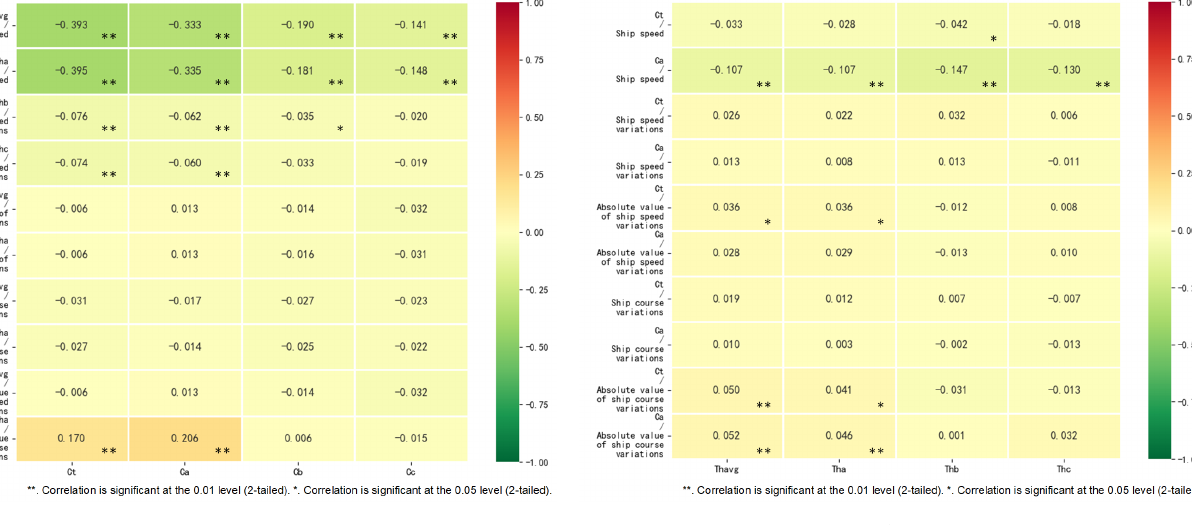
Figure 9. Partial correlation analysis. ( a ) Partial correlation analysis between sea ice conditions and ship movement characteristics with the control variable of ice thickness; ( b ) partial correlation analysis between sea ice conditions and ship movement characteristics with the control variable of ice concentration.